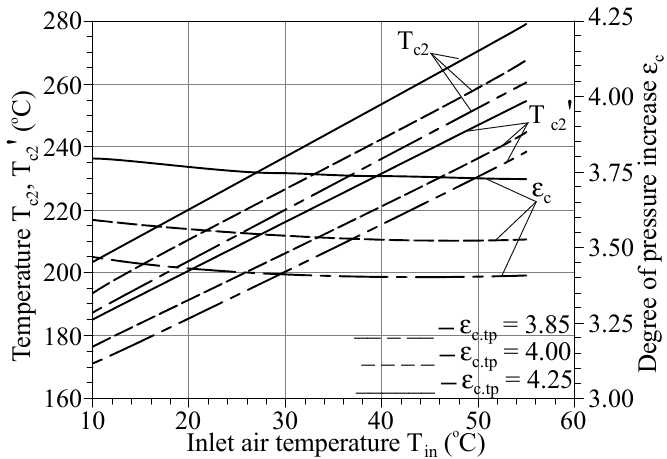
Figure 12. Dependences of the air temperature at the turbocharger discharge without a thermopressor, T c2 ; by using a thermopressor, T c2 ’; degree of pressure increase, ε c at different total pressure increase, ε c.tp , on the inlet air temperature, T in . For a system with total ε c.tp = 4.25, the decrease in compression work is ∆ l c = 10–13 kJ/kg; at ε c.tp = 4.00, the decrease in compression work is ∆ l c = 9.0–12.5 kJ/kg; and at ε c.tp = 3.85, the decrease in compression work is ∆ l c = 8.5–12.0 kJ/kg (Figure 13a,b). A decrease in work l c allows, at the same, air-flow rates on the internal combustion engine to reduce the compressor power by ∆ N c = 100–200 kW (10.0–11.5%) (Figure 13b).